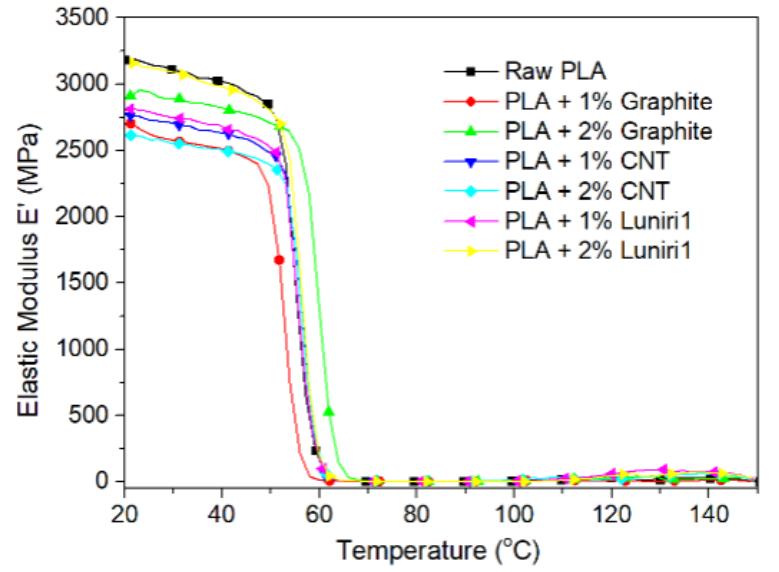
Figure 5. DMA result of PLA based filaments.